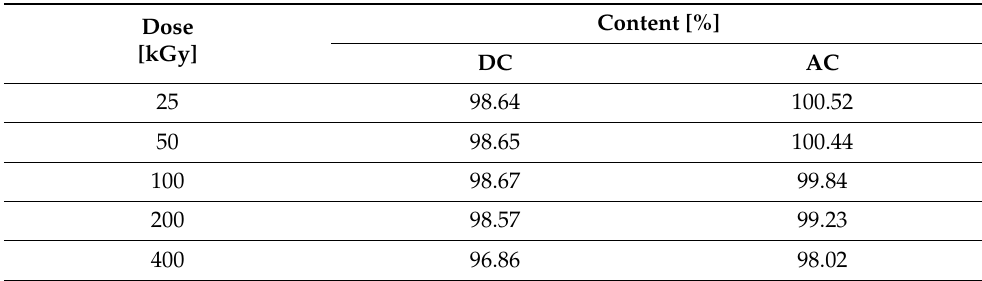
Table 6. HPLC analysis of AC and